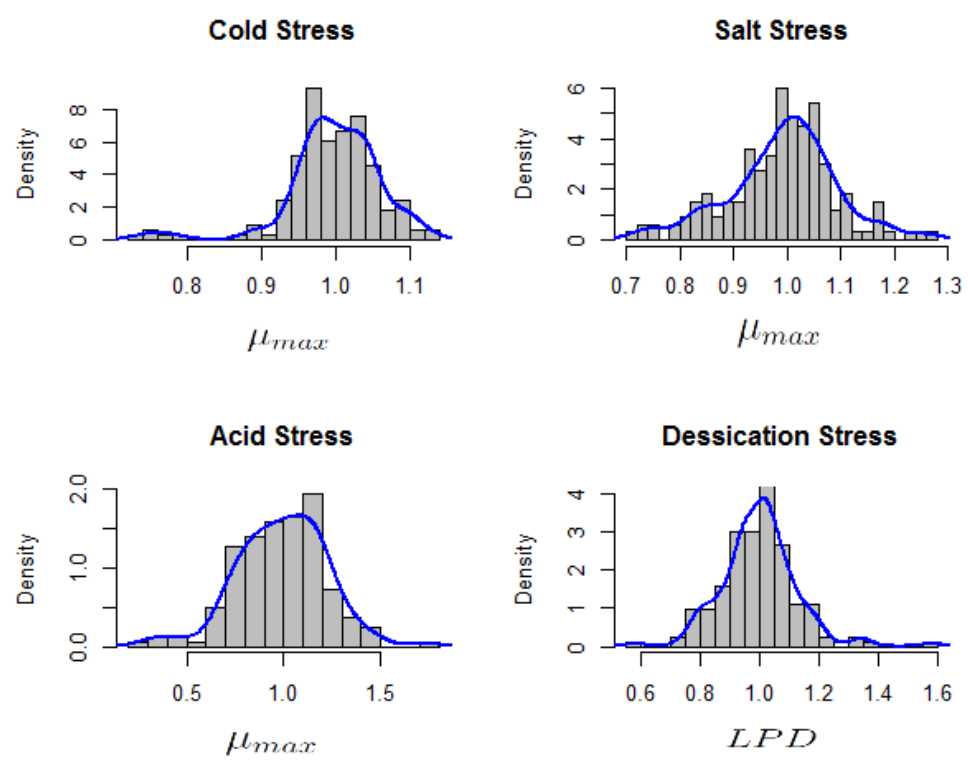
Figure 3. Histogram of relative maximum growth rates ( µ max ) for acid, cold and salt stress response and relative lag phase duration ( LPD ) of desiccation stress response in 166 L. monocytogenes